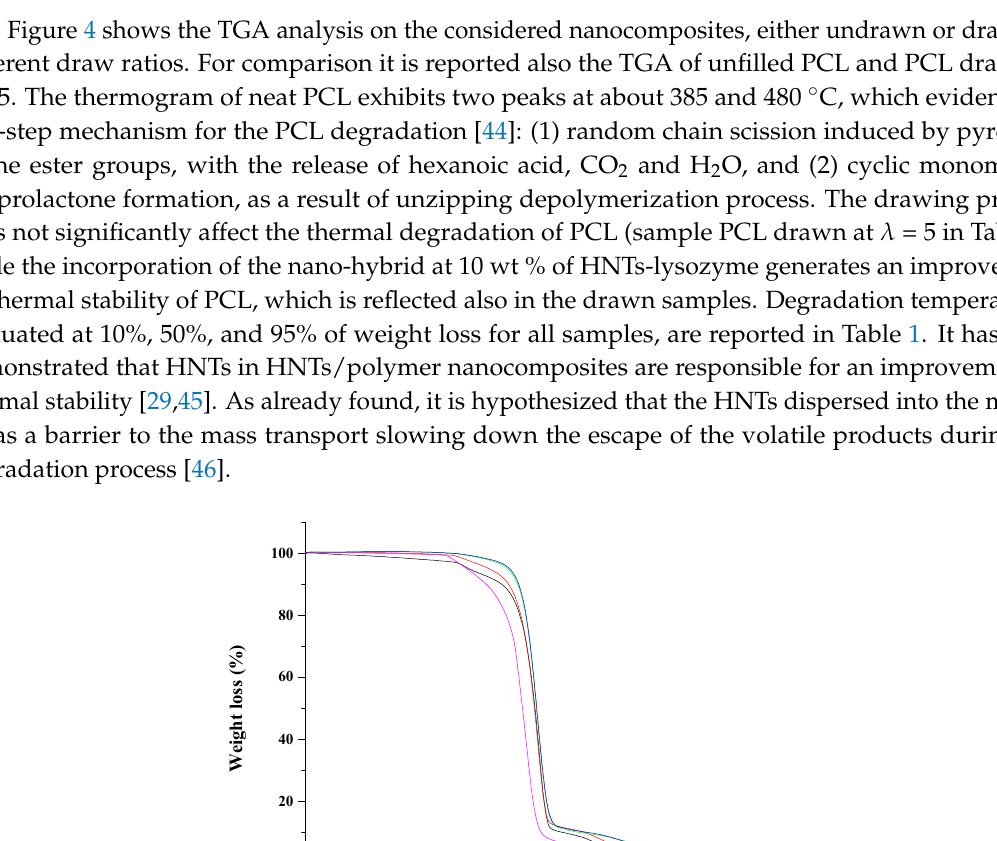
Figure 3. ATR spectra of ( A ): Undeformed nanocomposite ( ), drawn at λ = 3 ( ), drawn at λ = 4 ( ), and drawn at λ = 5 ( ); and ( B ) the ratio between absorbance bands of symmetrical (2850